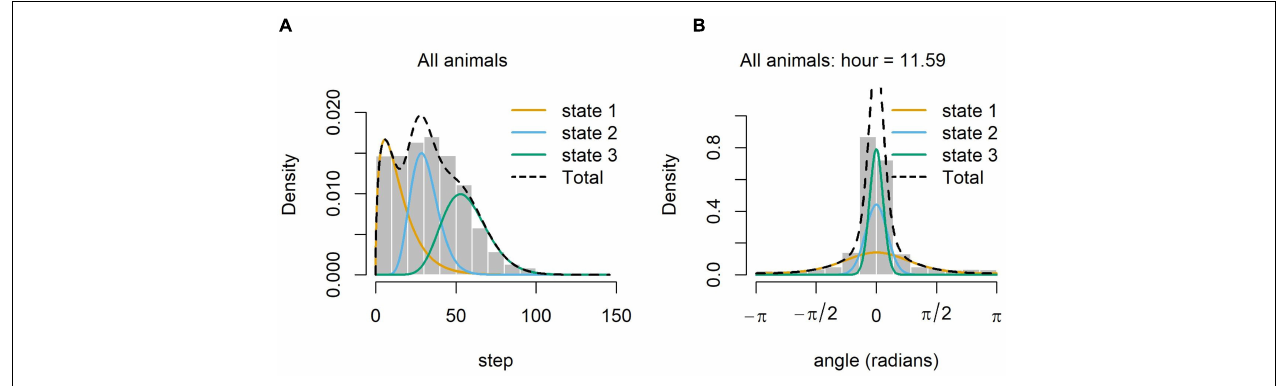
FIGURE 2 | Distributions of step lengths (km) and turning angles (degrees) for each behavioral state. Within each behavioral state, there is a range of step lengths and turning angles that can be associated with each point where the mean is the highest point of the smooth curve in both plots. Gray bars are histograms of the data. Plot (A) shows that the step lengths associated with state 1 are, on average, the shortest and the step lengths associated with state 3 are, on average, the longest. Step lengths associated with state 2 are usually between those of states 1 and 3. In (B) , the distributions of turning angles are shown for each state. Although the mean turning angle for all states was around 0, the distribution curve for state 3 is much steeper and tighter around 0 than those of states 1 and 2, which means that the turning angles associated with each state 3 point are most likely to be close to 0. The much flatter curve of state 1 means that sharper turning angles are more likely in this state. Again, the distribution of state 2 is between that of states 1 and 3.